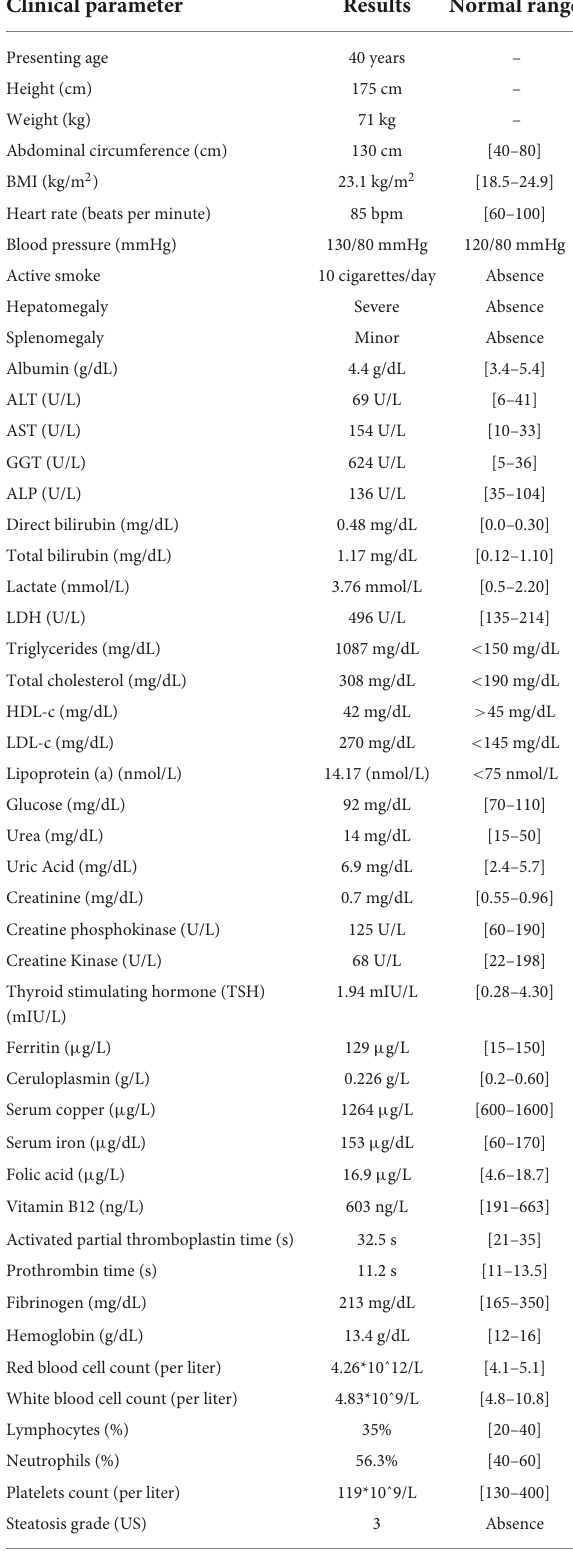
TABLE 1 Clinical and laboratory findings of a 40-year-old woman with non-alcoholic fatty liver disease. Clinical